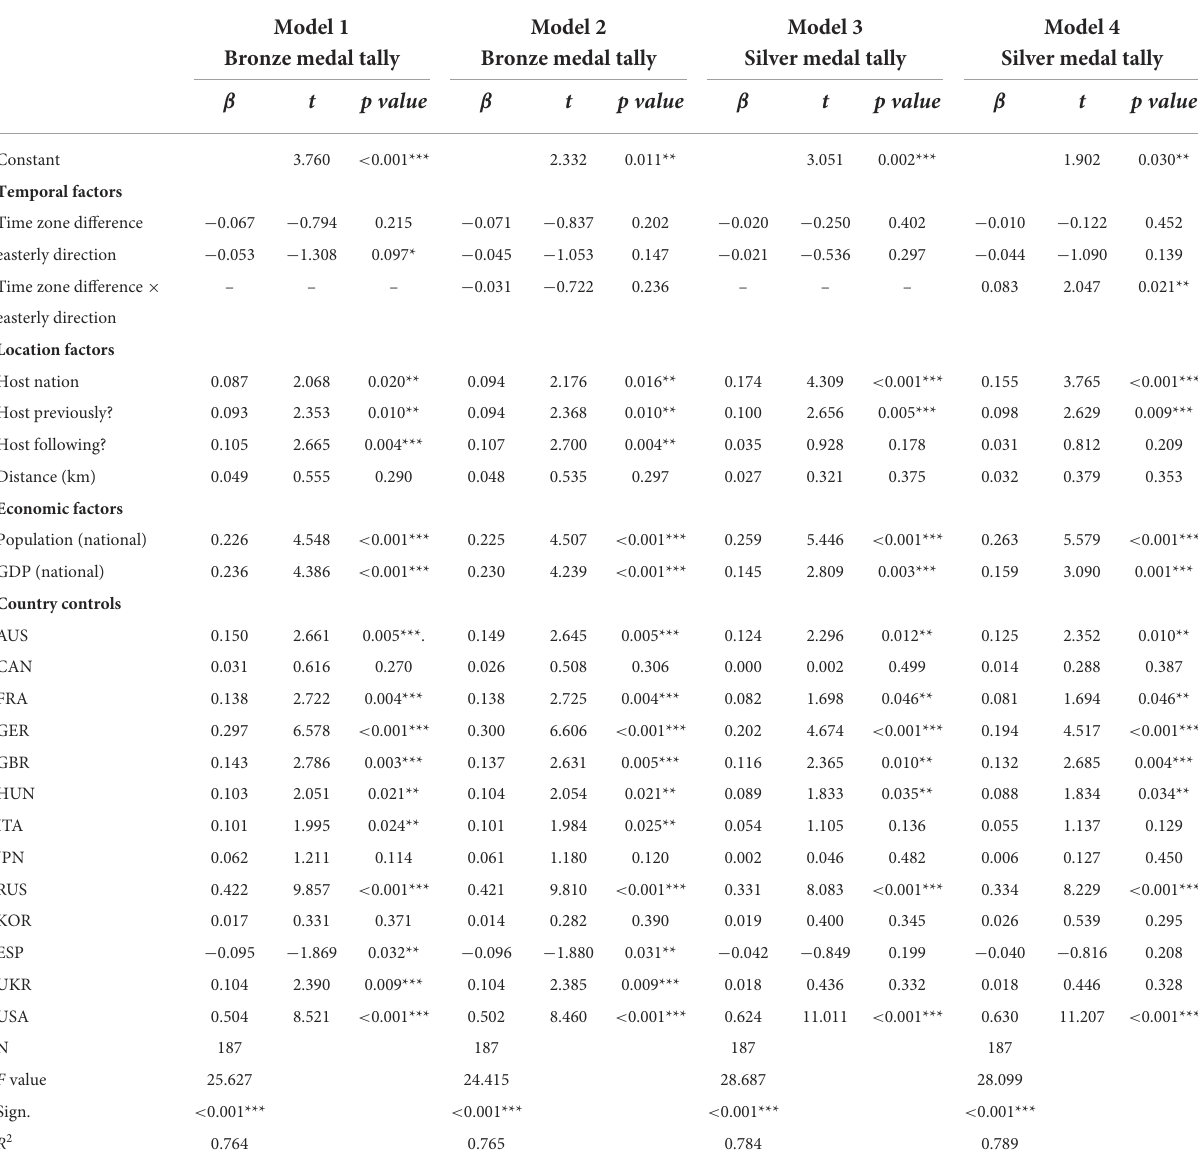
TABLE 3 Multiple regression results for medal